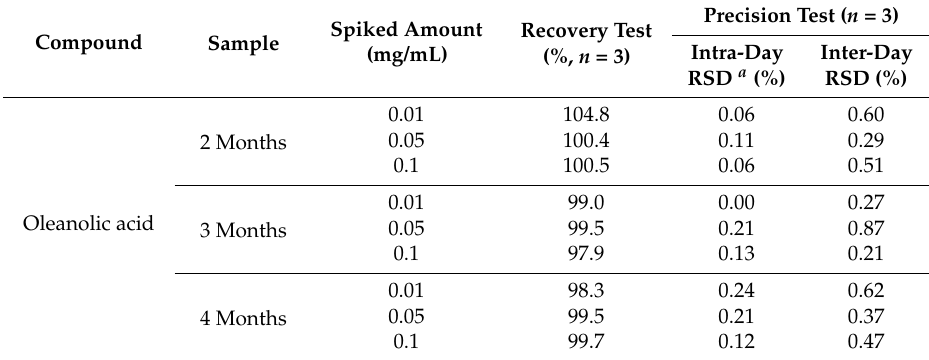
Table 3. Accuracy and the intra- and inter-day precision of oleanolic acid and ursolic